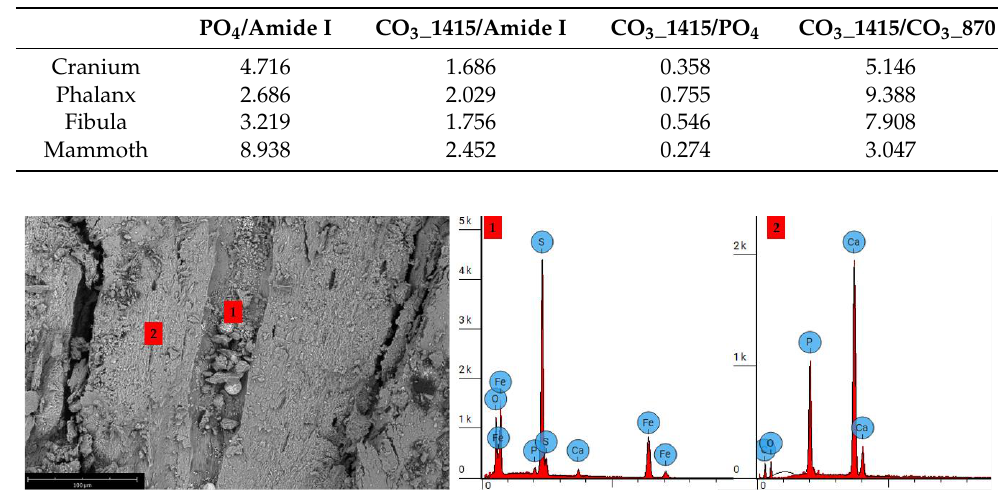
Table 5. Degree of mineralization (PO 4 /amide I), amount of carbonate to organic matrix (CO 3 _1415/amide I), carbonate to phosphate mineral content (CO 3 _1415/PO 4 ), and carbonate in the bone mineral and substituted carbonate (CO 3 _1415/CO 3 _870) determined by ATR-FTIR spectrometric analyses.